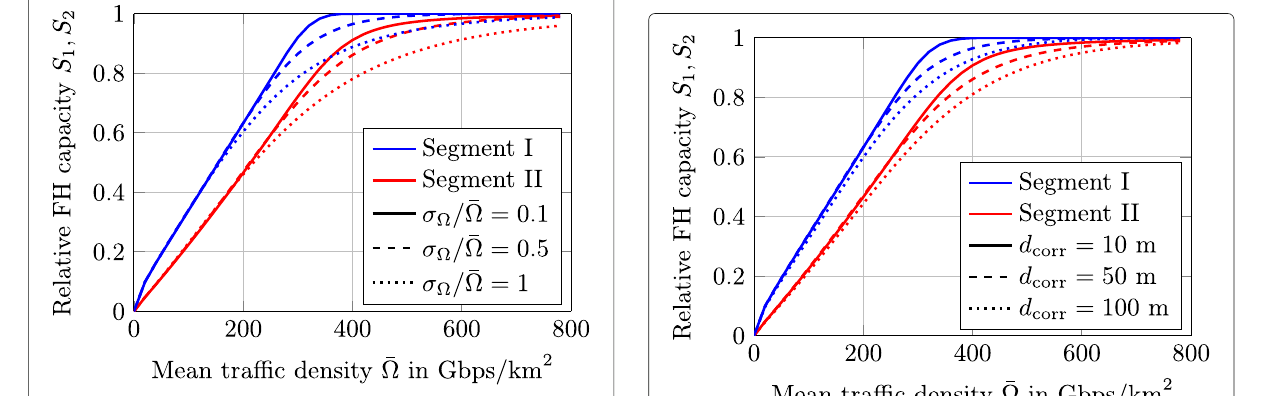
Fig. 8 Impact of standard deviation. Relative FH capacity for different relative standard deviations of the traffic density, d corr = 50 m, P O = 0.01